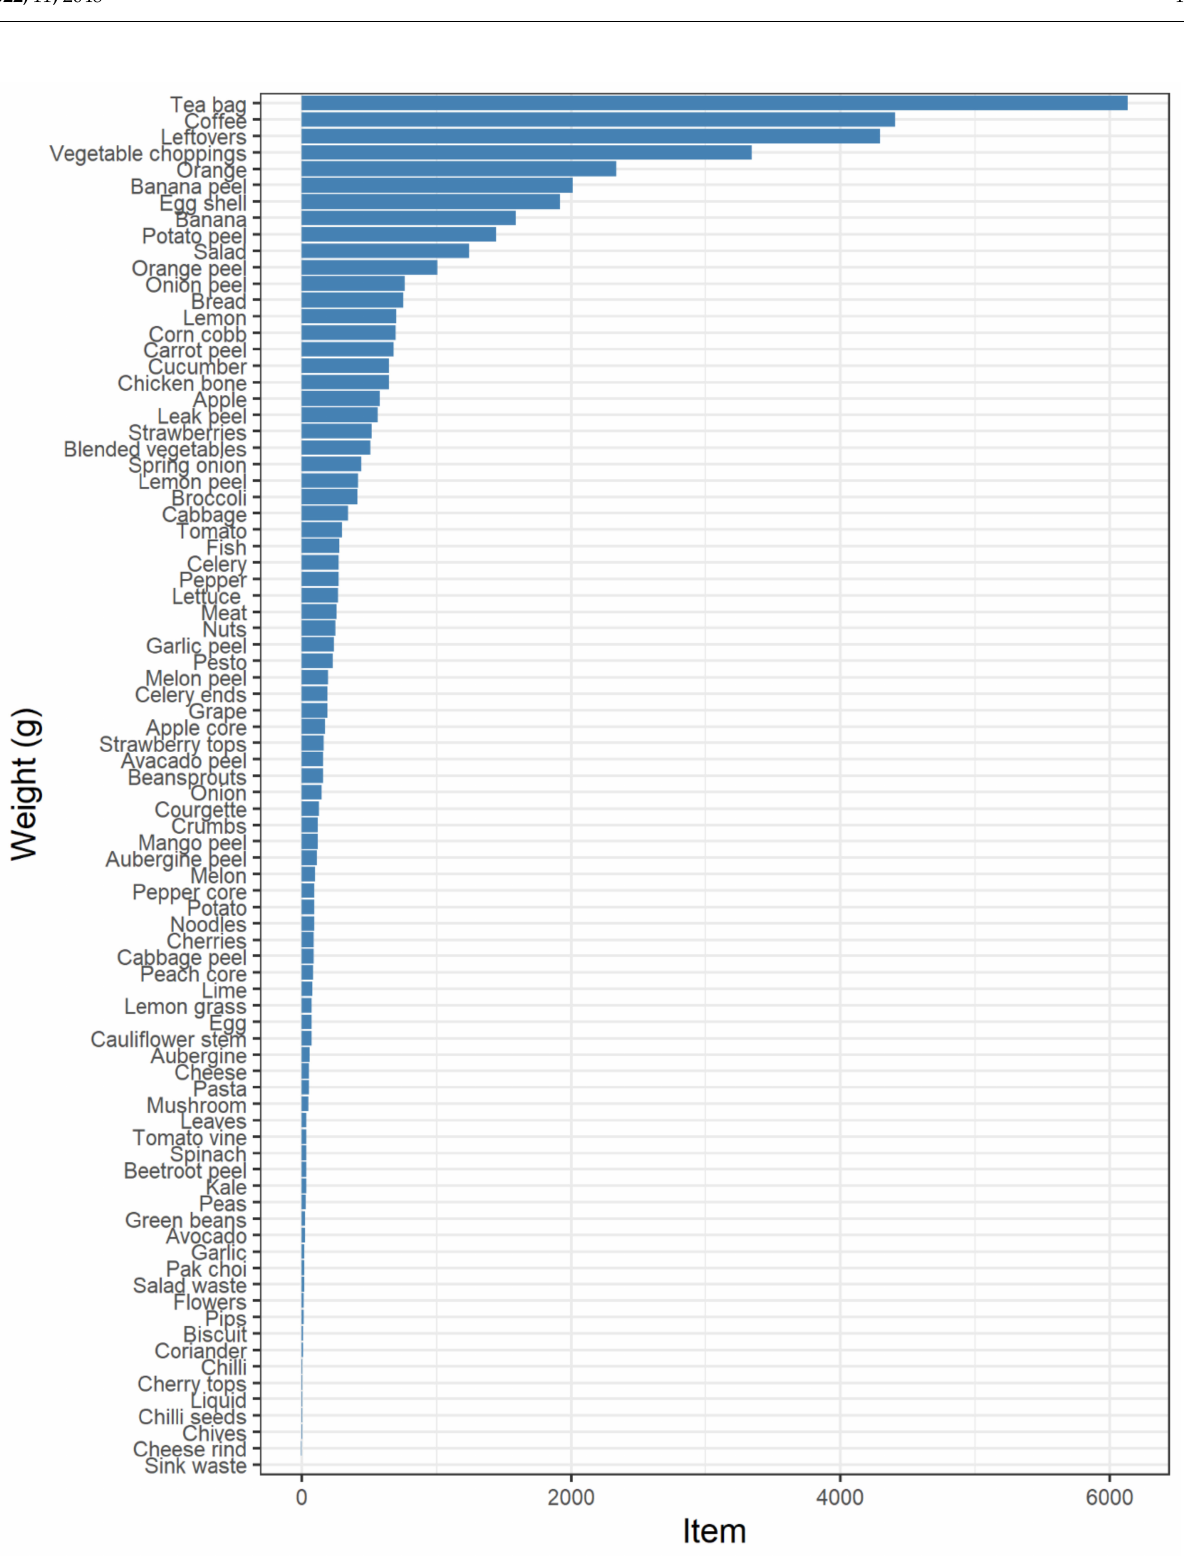
Figure 5. Total weight of each